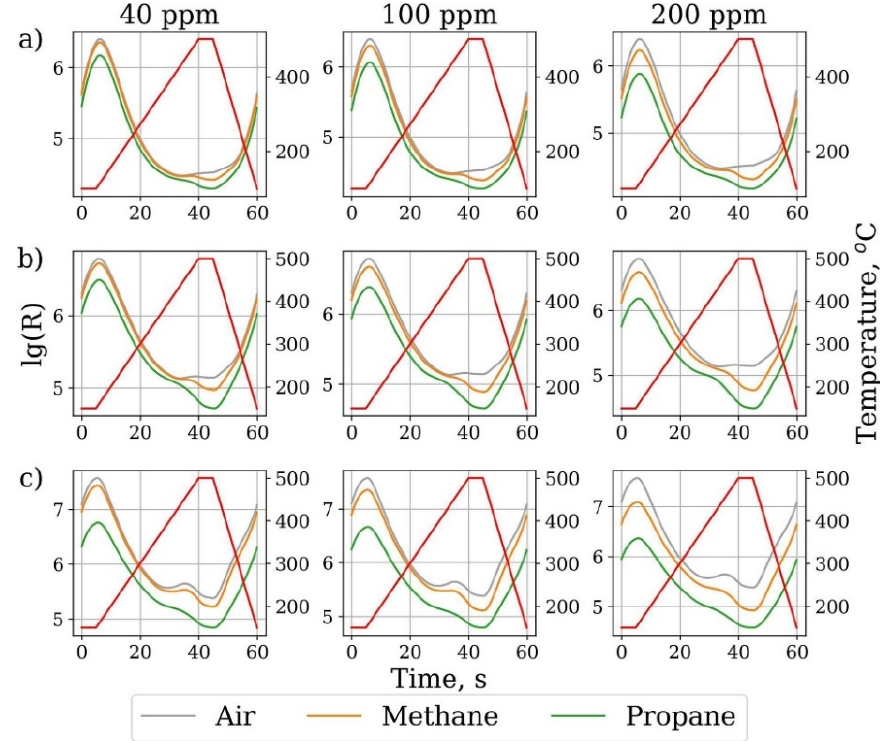
Figure 12. Schematic diagram of temperature modulation. Reprinted from [142] copyright (2021), with permission from Elsevier. ( a ) SnO 2 sensors towards air, methane, and propane at different concentrations during a temperature modulation cycle; ( b ) Au-SnO 2 sensors towards air, methane, and propane at different concentrations during a temperature modulation cycle; ( c ) Au/Pd-SnO 2 sensors towards air, methane, and propane at different concentrations during a temperature modulation